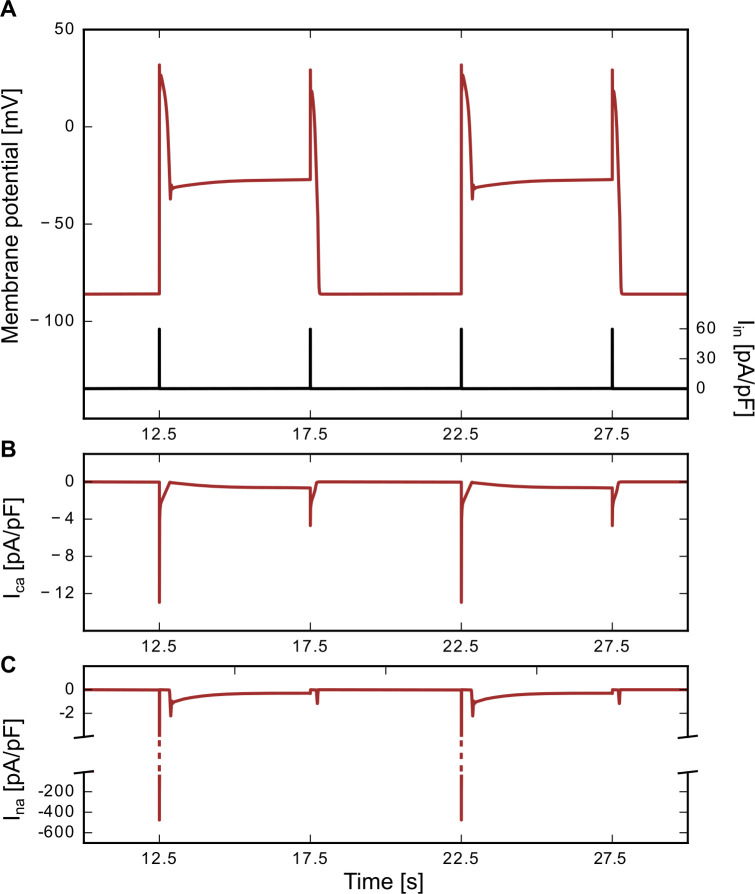
Example trace for N1659A mutation.(A) Action potential trace for the N1659A sodium channel mutants activation and inactivation curve [6]. The midpoint voltage of the activation curve was set to V1/2 = -23.7 mV and the midpoint-voltage of the inactivation curve, was set to V1/2 = -52.6 mV. The plot shows a part of a simulation with a stimulation pulse every 5 s (pulse amplitude A = 60 pA/pF, pulse length l = 2 ms, period P = 5 s, time delay t0 = 2.5 s). The current trace is included (black line). (B) Calcium and (C) sodium current traces corresponding to the action potential simulations in A.